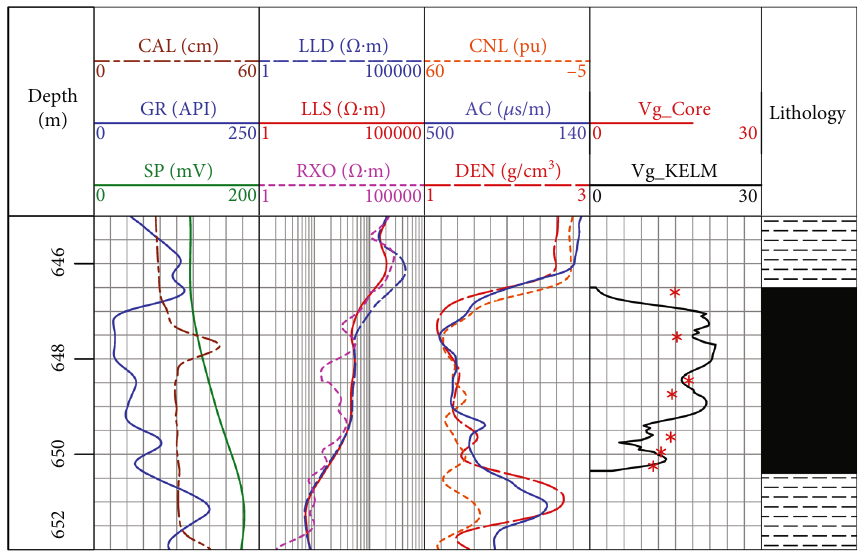
Figure 17: Application of CBM content model constructed by KELM method in a new